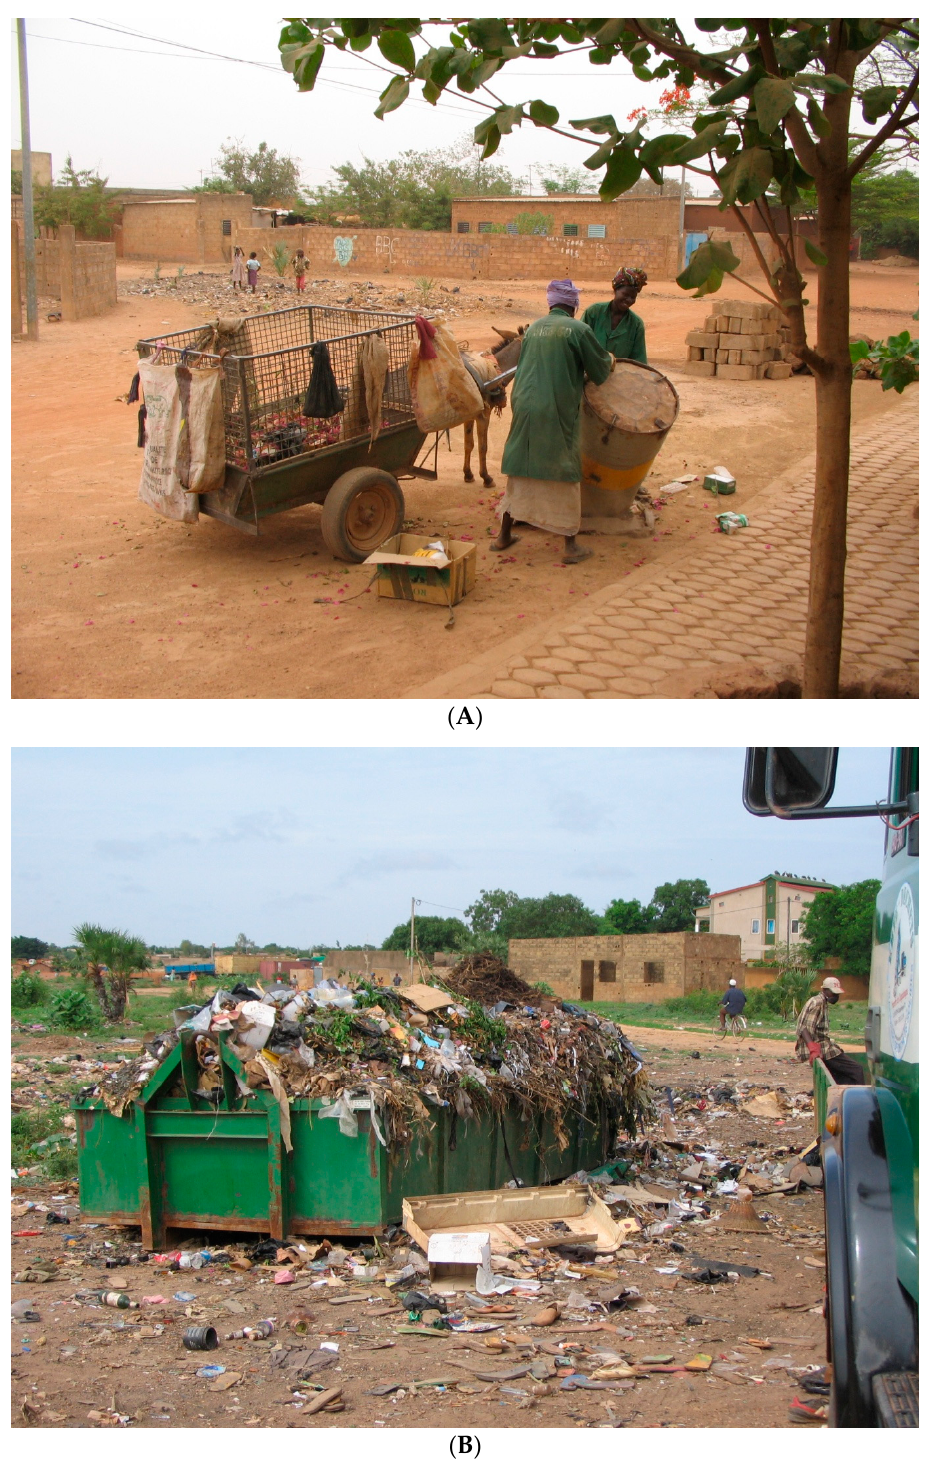
Figure 2. Photographs showing different waste collection modalities. ( A ) Households can start a monthly subscription with an association; here, two women are collecting waste in Gounghin with a donkey car; ( B ) Dumpster full of waste in a street of Gounghin, allowing Aedes mosquitoes to develop during the first rainfall.